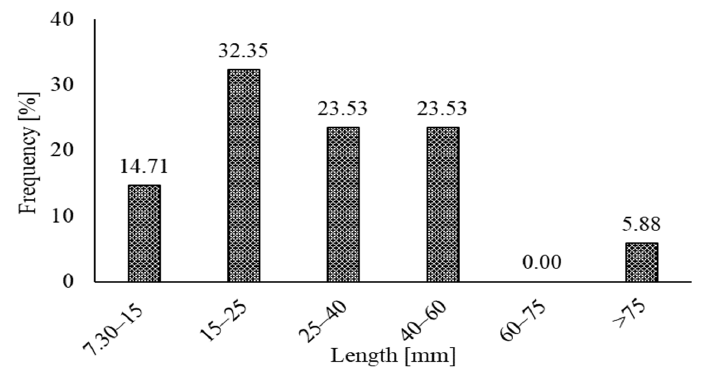
Figure 2. Frequency of RSFs for various ranges of lengths.